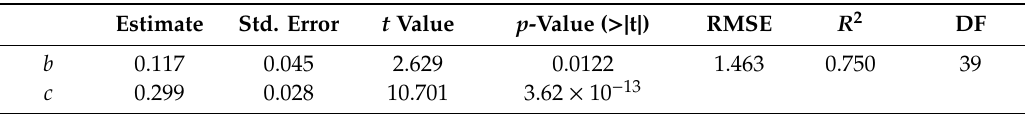
Table A2. Parameter estimates and goodness-of-fit statistics for the poplar stumps model with the equation DM st = b × e cD .